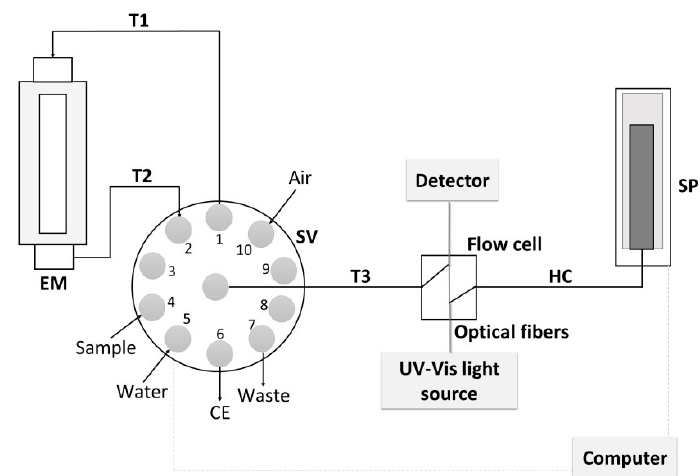
Figure 2. Scheme of the developed flow system with the evaporation module (EM); SV—selection valve, SP—syringe pump, HC—holding coil, T (1–3)—tubing, CE—capillary electrophoresis system.